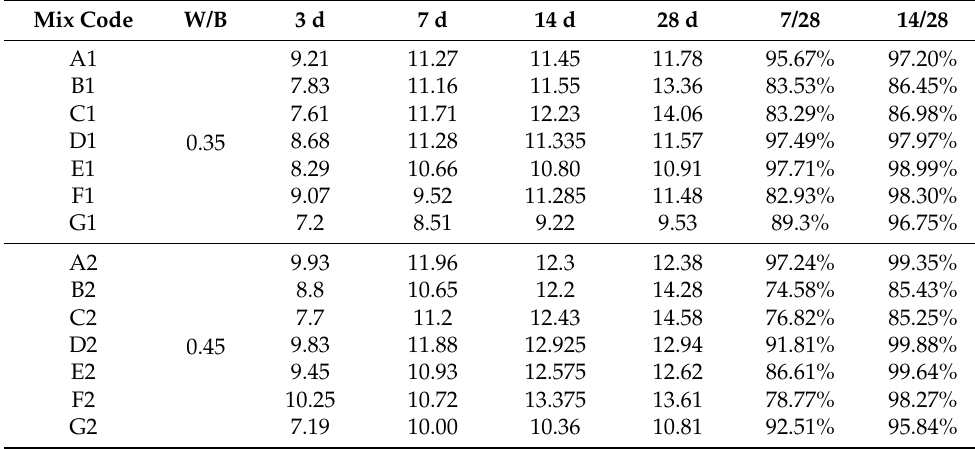
Figure 4. Influence of mineral admixtures on chemically bound water content. ( a ) 0.35; ( b ) 0.45. Table 4. Chemically bound water